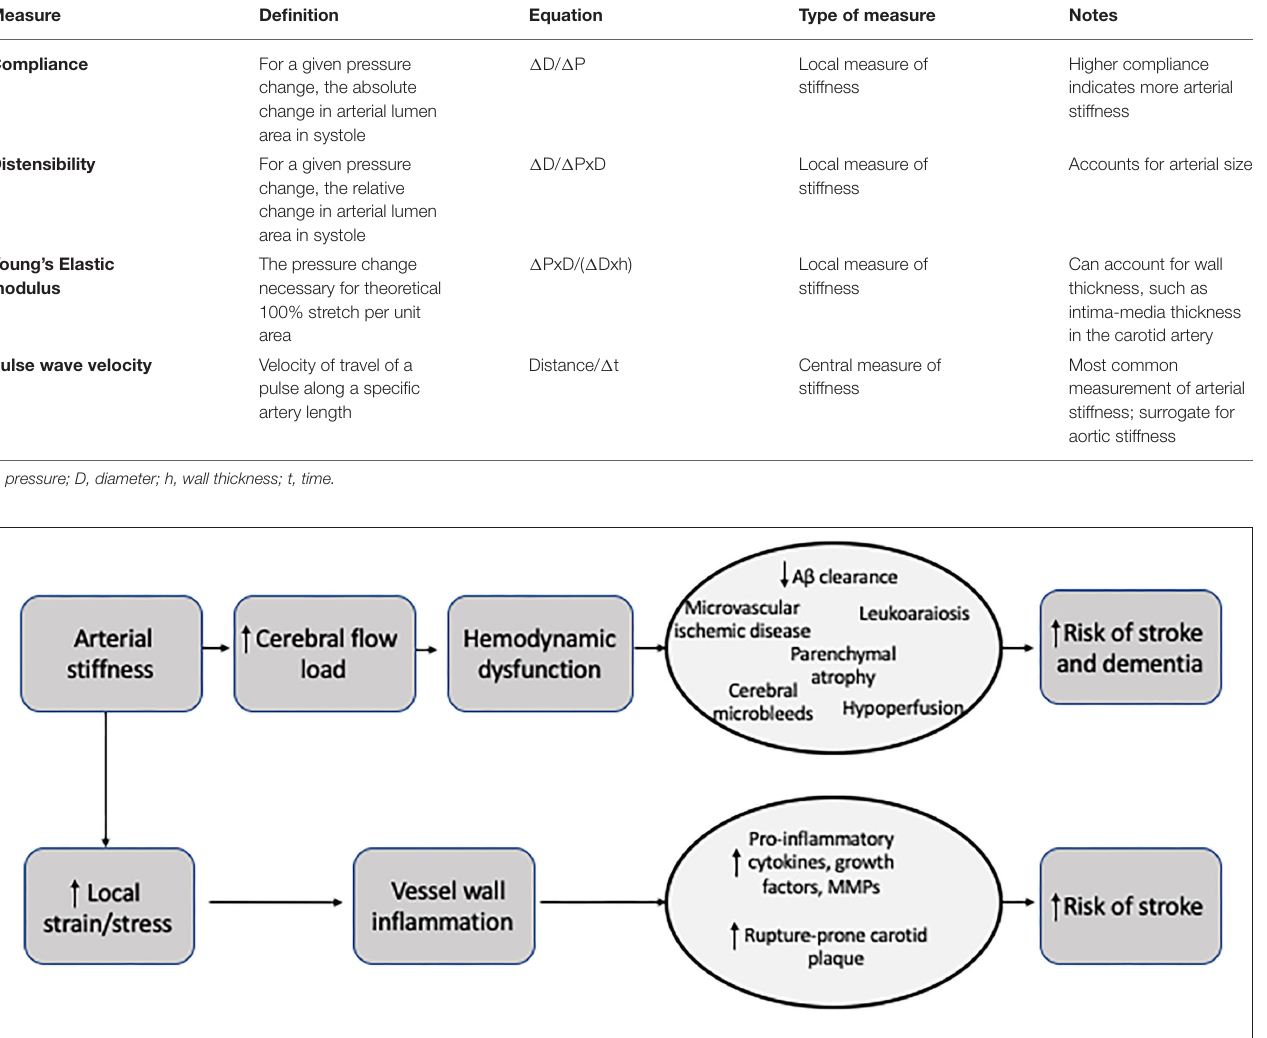
FIGURE 1 | Schematic representation of changes to an artery wall in diastole compared to systole. The change in the diameter of the lumen is used in all local stiffness